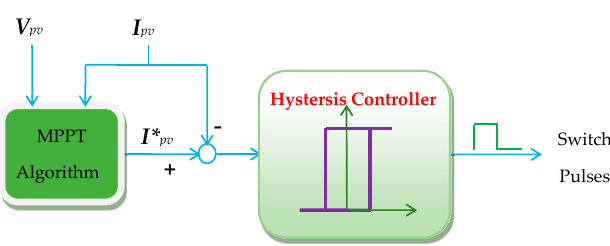
Figure 5. Maximum power point tracking (MPPT) controller block diagram.